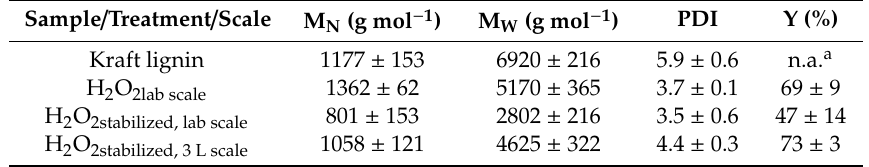
Table 1. M W , M N , and PDI of KL and OKL after oxidation with non-stabilized and stabilized H 2 O 2 at a laboratory scale and a 3 L scale, as well as respective OKL yields (reaction